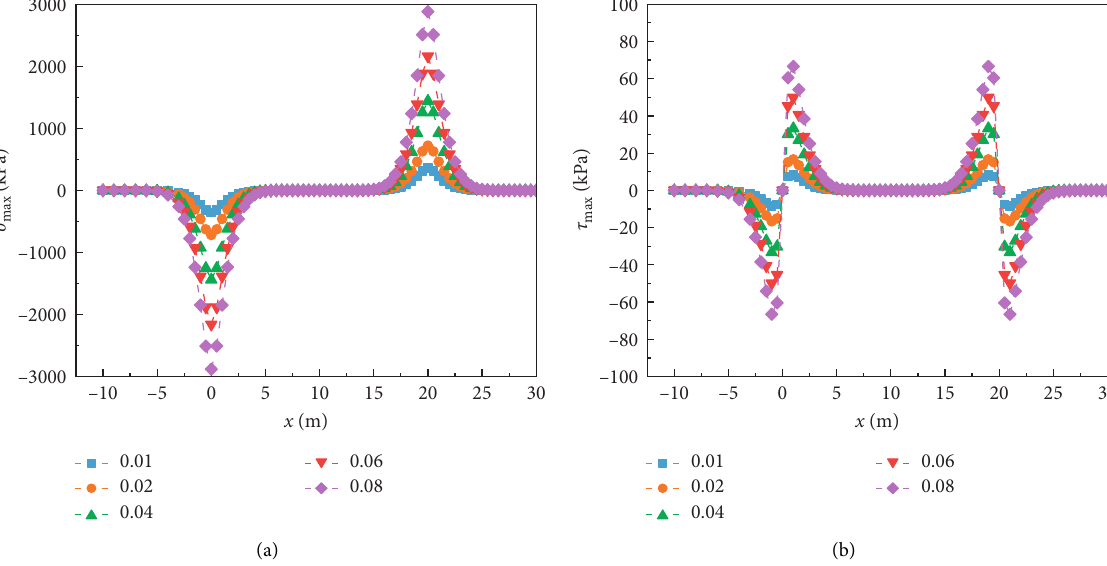
Figure 10: Distribution law of maximum normal stress and maximum shear stress of the lining cross-section under different frost heave amounts.